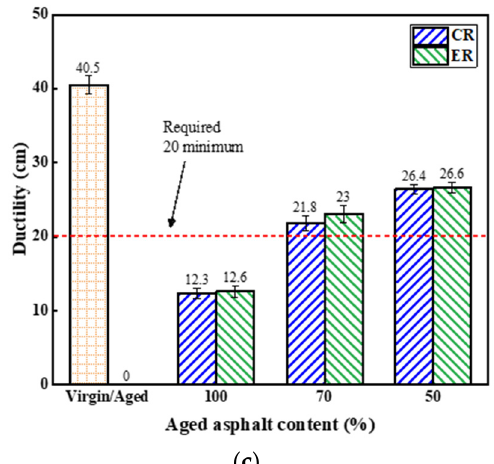
Figure 7. Three indexes of different asphalt binders: ( a ) softening point; ( b ) penetration; ( c ) ductility.